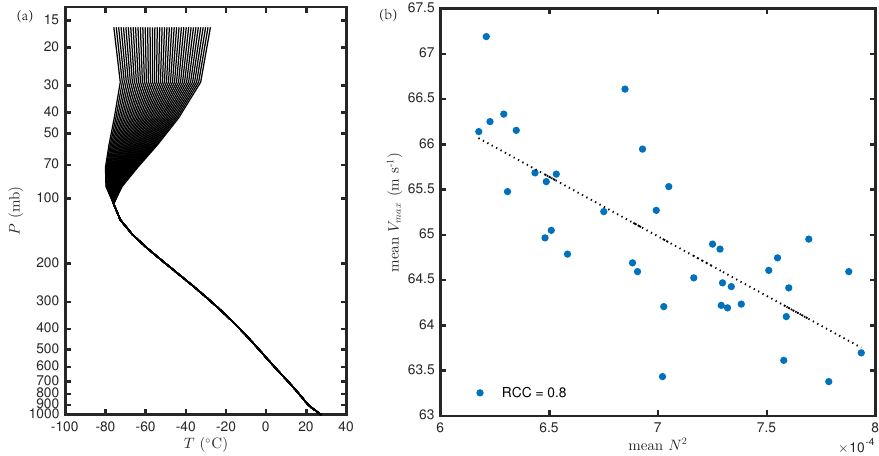
Figure 12. ( a ) A range of initial soundings (solid lines) used in the N 2 set of experiments, and ( b ) dependence of the 1000-day mean maximum tangential wind V max on the mean stratospheric stratification N 2 . Dashed line denotes the linear best